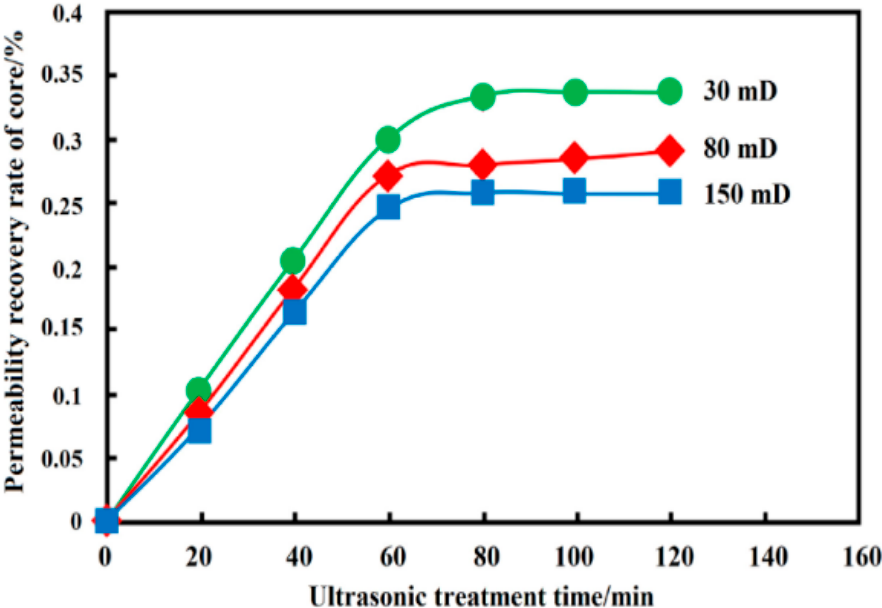
Figure 7. How ultrasound affect the removal of colloidal precipitates in core (reprinted from Mo et al. [29] Copyright 2020, LN 5341881386348, with permission from Elsevier) .